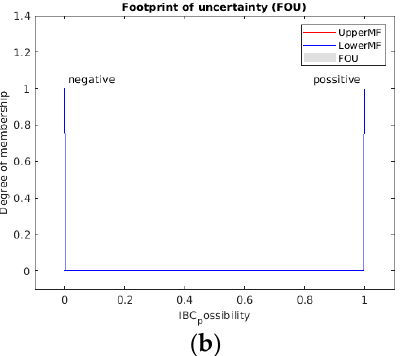
Figure 12. ( a ) Three inputs proposed membership functions of Type-1 fuzzy system. ( b ) Output membership function used in the designed Type-2 fuzzy system.